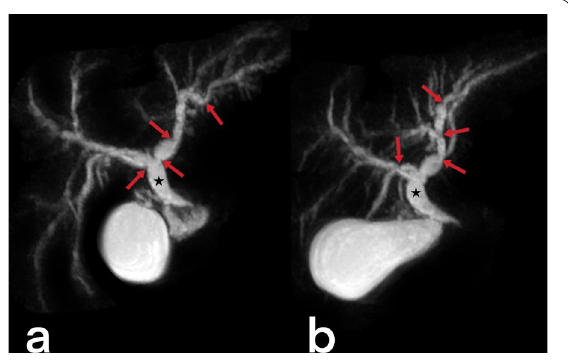
Fig. 31 A 35-year-old male. Magnetic resonance cholangiopancreatography (MRCP) images ( a , b ) show extensive multifocal intrahepatic biliary strictures (arrows) and dilated common hepatic duct (star)